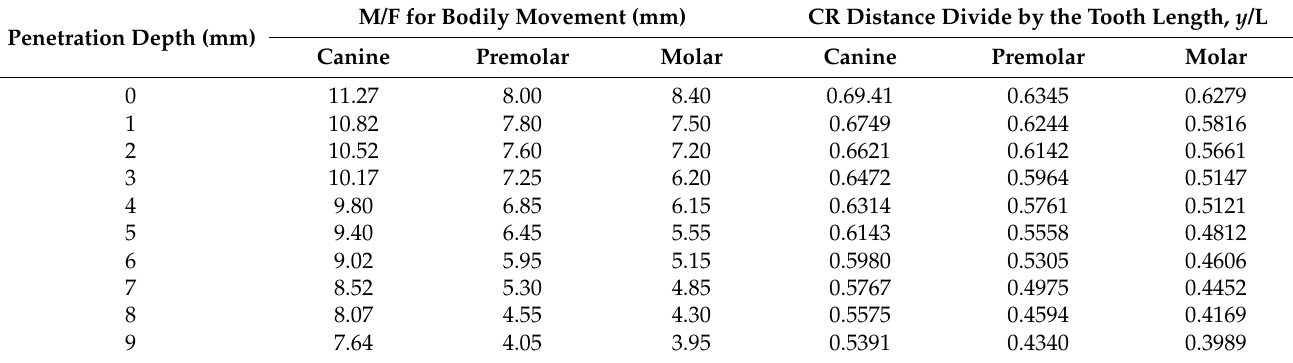
Table 3. The CR position and the M/F for teeth with various penetration depths.